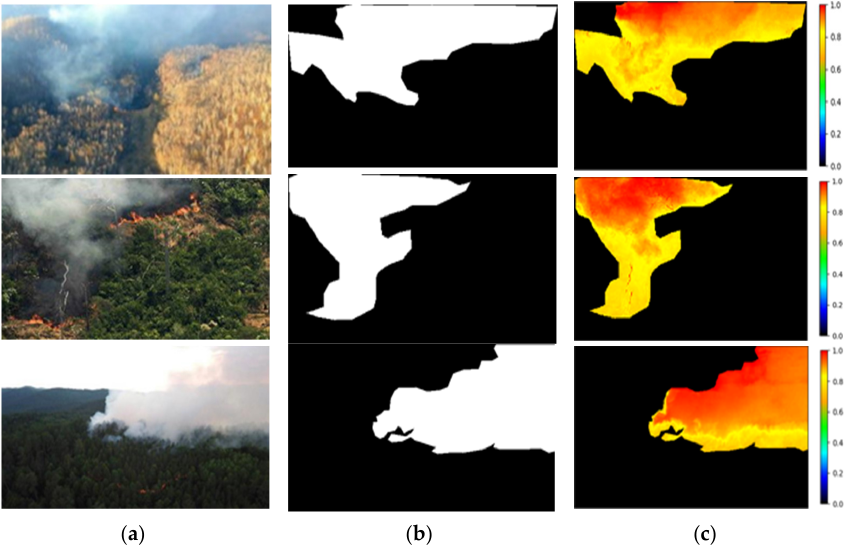
Figure 2. Original image, GT image and weighted image. ( a ) The original image. ( b ) The GT image. The white area with the pixel value of 1 is the smoke area and the black area with the pixel value of 0 is the non-smoke area. ( c ) The weighted image. The pixel value of the smoke area is distributed between [0,